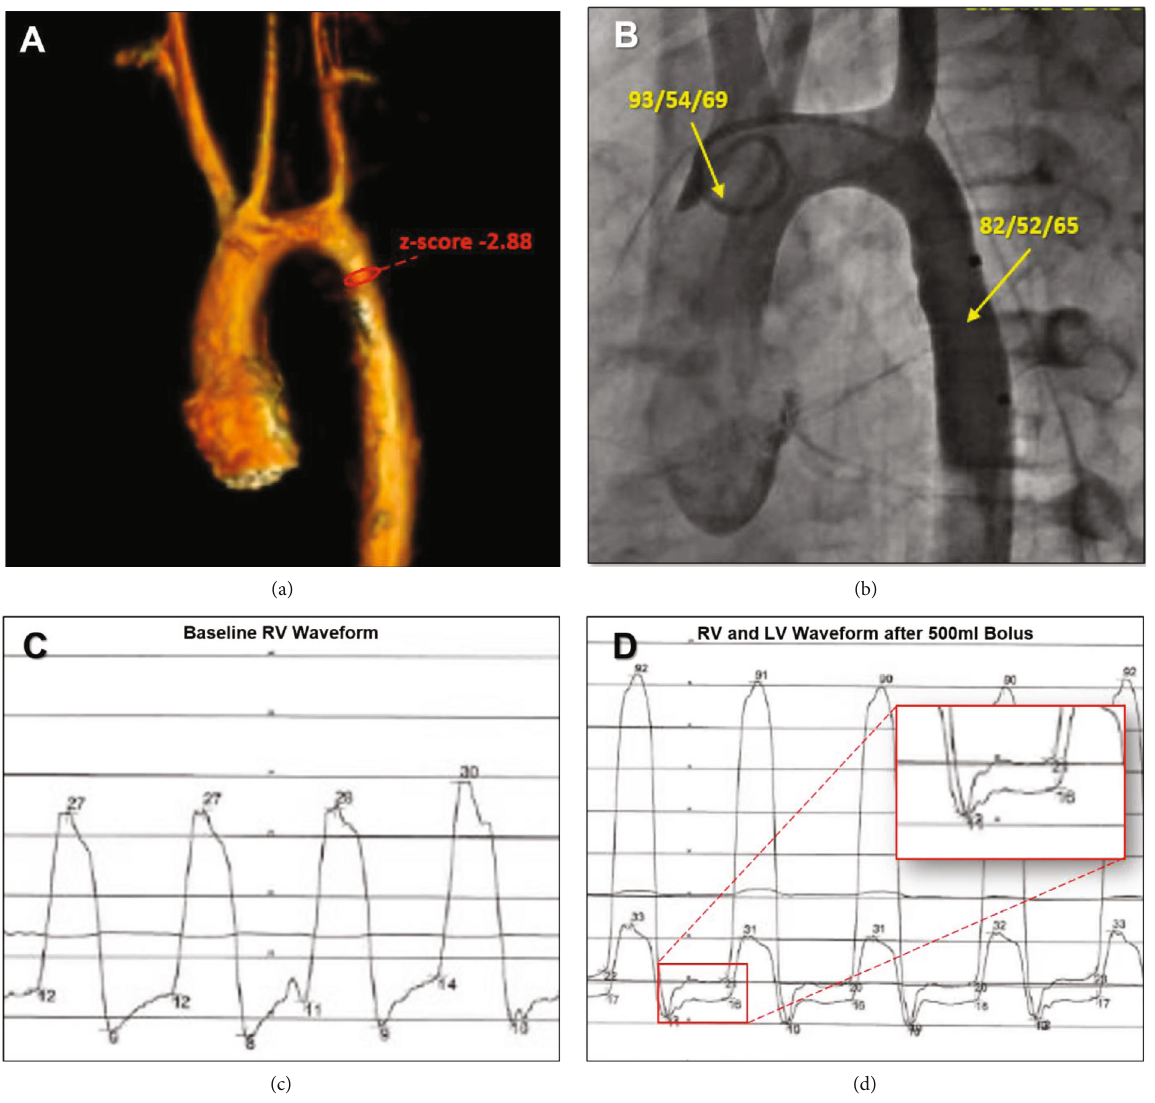
Figure 1: Cardiac MRA, aortic arch angiography, and hemodynamic waveforms before and after volume challenge. (a) Cardiac MRA showed a crenellated arch with hypoplasia of the proximal descending thoracic aorta ( z -score of – 2.88), but no discrete coarctation. (b) Catheterization was performed and con fi rmed no arch gradient. (c) Pressure tracings document an elevated RVEDp (12 mmHg) and LVEDp (16 mmHg) but with grossly normal diastolic waveforms at the start of the case. (d) After a 500 mL bolus, RVEDp and LVEDp increased to 16 and 20 mmHg, respectively, and dramatic change in the diastolic waveforms was observed with unmasking of a “ classic ” square root sign and concordant RV/LV respirophasic